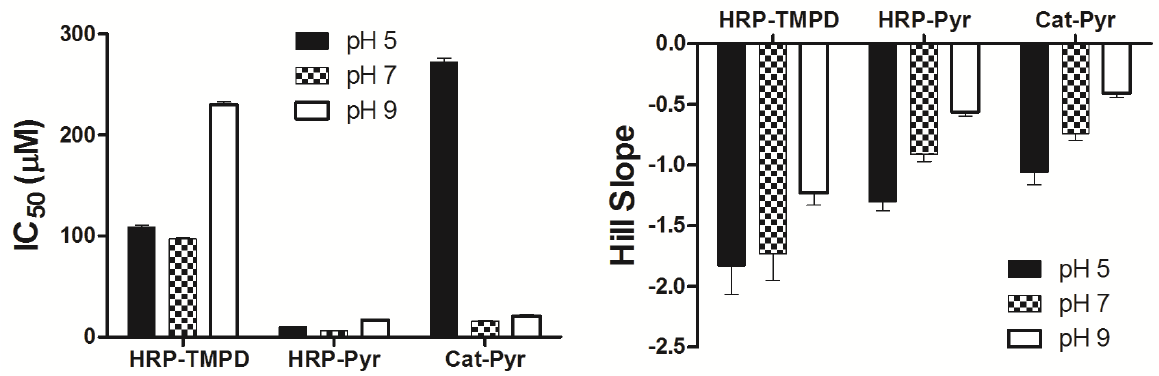
and Hill slopes for the one-electron oxidation of pyrogallol by HRP and 50